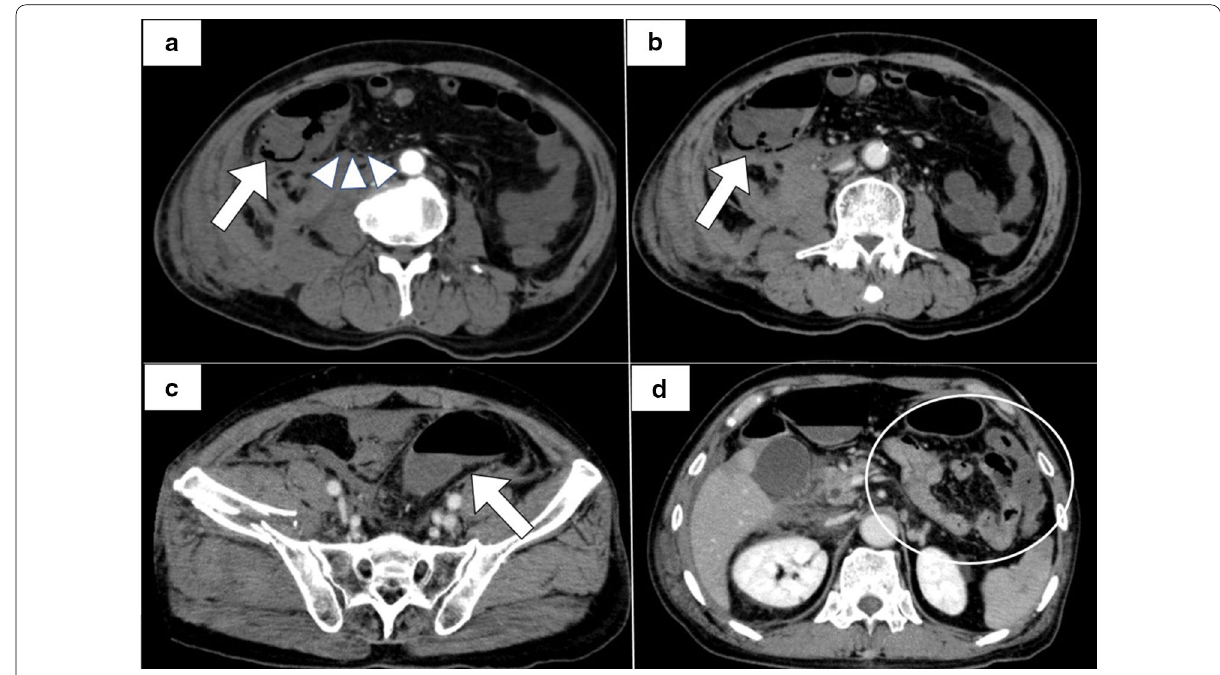
Fig. 2 CT findings on day 3: a the early arterial phase; b – d the portal venous phase. a Thickening ascending colon wall, intramural emphysema (arrow), and a slight amount of air in the mesenteric vein (arrowhead). b Intramural emphysema in ascending colon (arrow). c Dilated sigmoid colon (arrow). d Small intestine with no evidence of necrosis (circle)